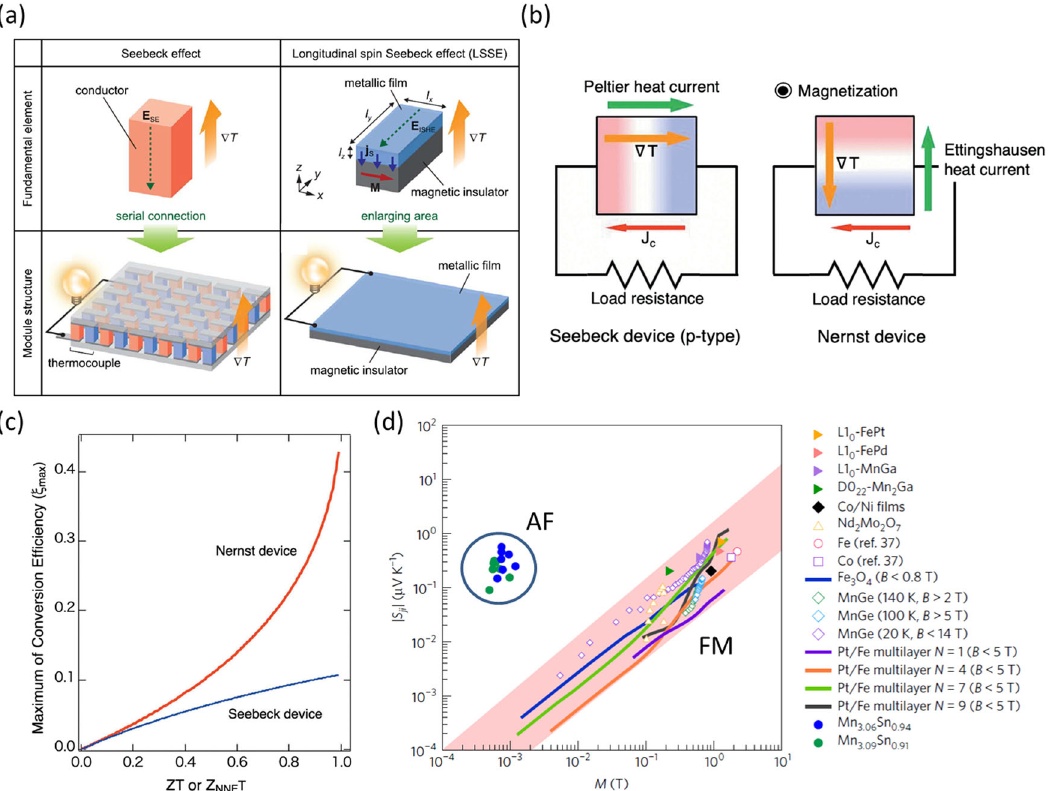
Fig. 8 Spin thermoelectric generation mechanism. a Comparison between fundamental element of a Seebeck effect device and longitudinal spin Seebeck effect device, and their corresponding module architectures (2016 IEEE, reprinted, with permission from ref. 54 ). b , c Show the schematics of the thermoelectric conversion mechanism for a Seebeck device and a Nernst effect device, and comparison of the maximum conversion ef fi ciencies ζ max under a temperature gradient Δ T = 300 K ( fi gures reproduced from ref. 55 ). d Comparison of Nersnt signals S ji for ferromagnets (FM) and the non-collinear antiferromagnet (AF) Mn 3 Sn. Adapted from ref. 56 by permission from Springer Nature, ©2017.